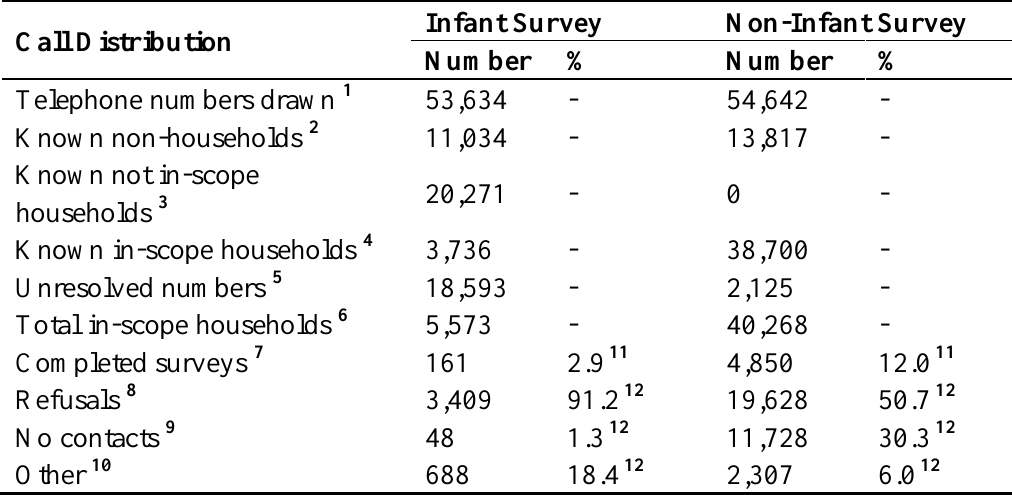
Table 1. CHAPS 2 survey response by call